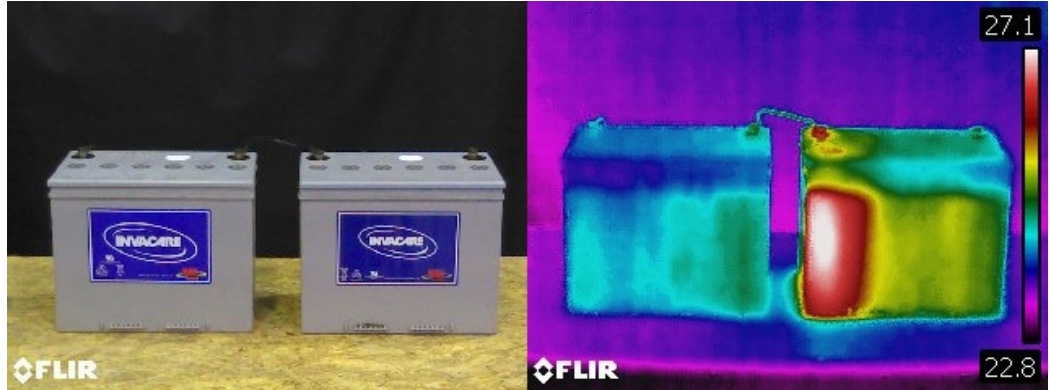
Figure 1. Thermogram of damaged and undamaged